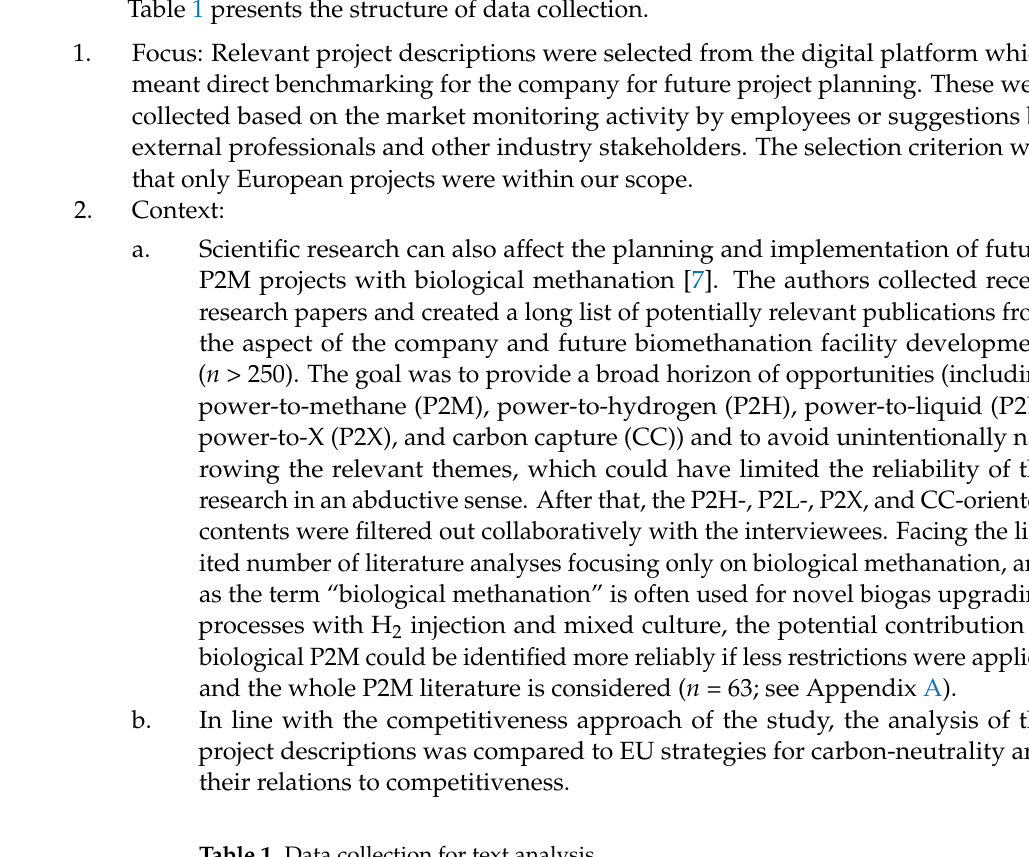
Table 1. Data collection for text